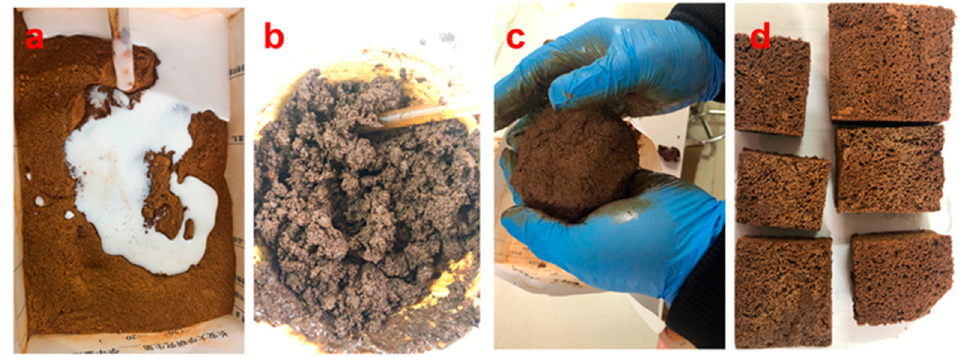
Figure 1. Synthesis of novel alum sludge-based FTWs substrate. ( a ) alum sludge mixed with organic foaming materials; ( b ) stirring and forming; ( c ) granulation; ( d ) natural drying.